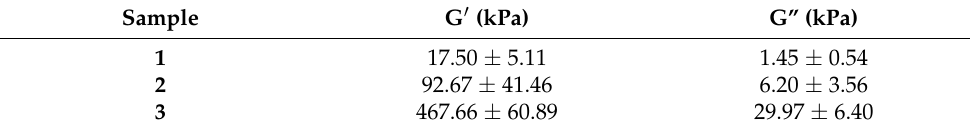
Table 2. G’ and G” moduli from amplitude sweep ( γ = 0.046%) for compounds 1 – 3 .